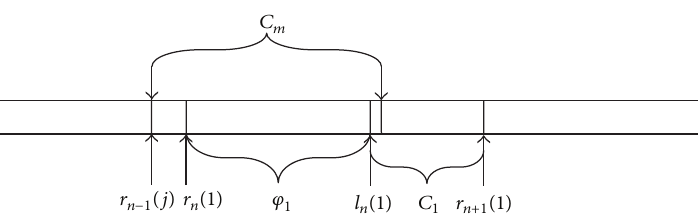
Figure 4: 𝐶 𝑚 starts to execute before 𝑟 𝑛 (1) and still executing beyond 𝑙 𝑛 (1)